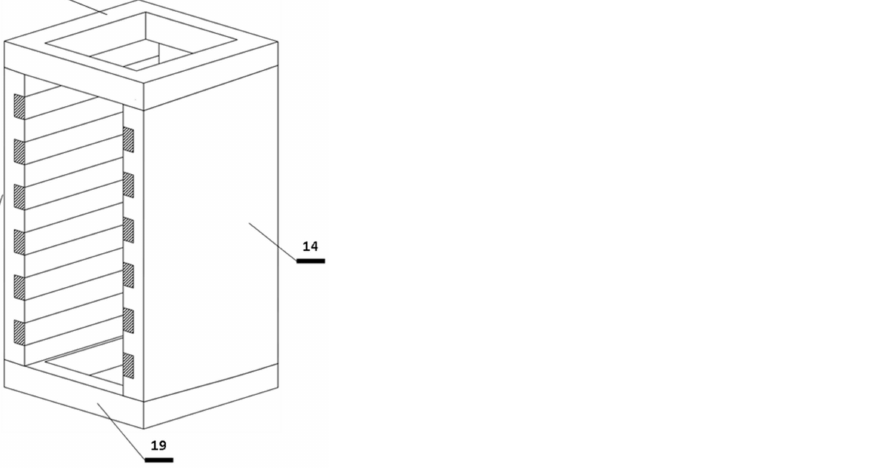
Figure 8. Axonometric image of TMF twin inductor constructed completely (with inlets formed in the ferromagnetic bridges ”19”, in which the solidification channel ”21”will be placed) without demonstrating the coil